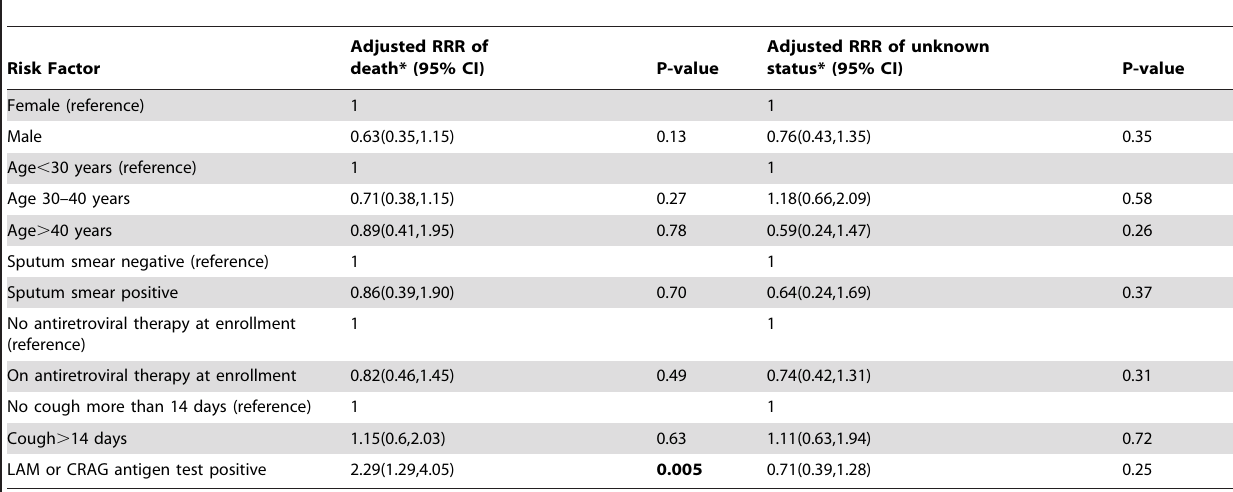
Table 2. Adjusted relative risk ratios (RRR), 95% confidence intervals (CI), and P-values for risk factors for death at 2